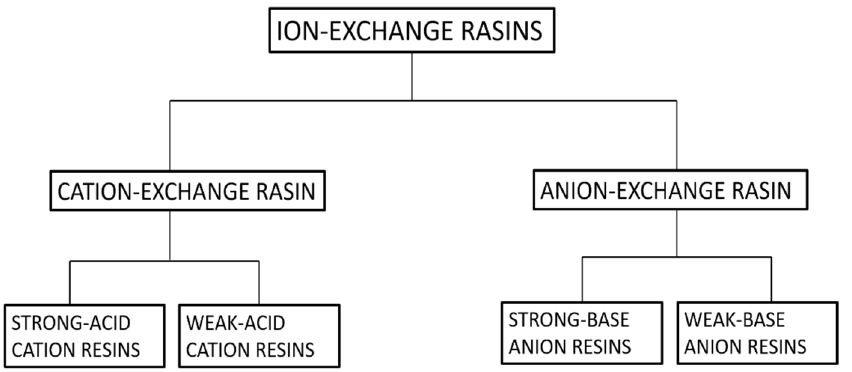
Figure 10. Classification of ion-exchange resins.